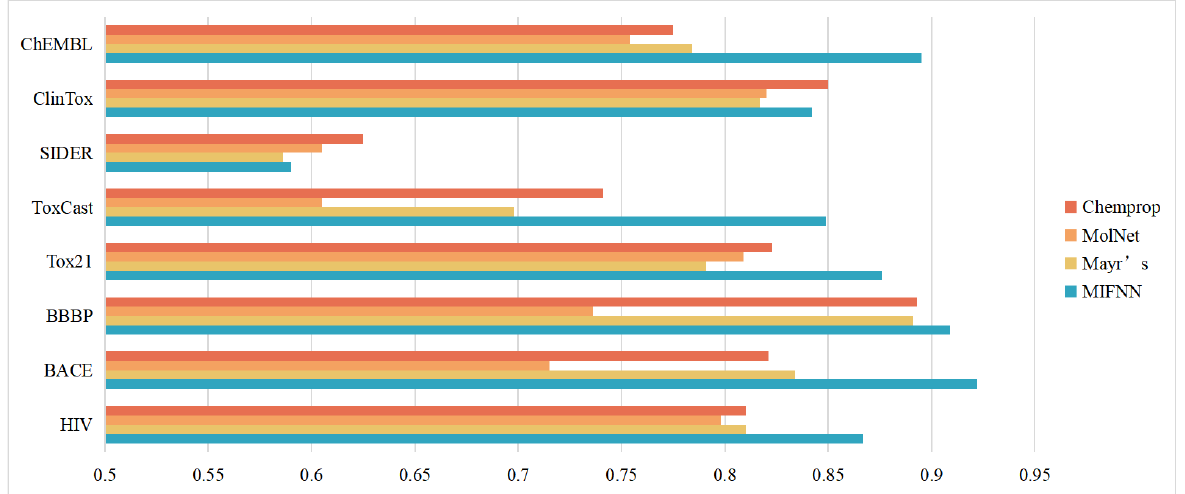
Figure 7. Comparison results with baseline models.